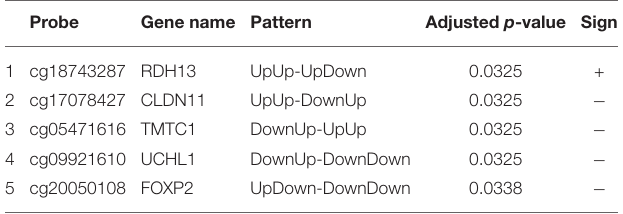
TABLE 1 | Significant genes for diagnosis of gastric cancer by Cox model.